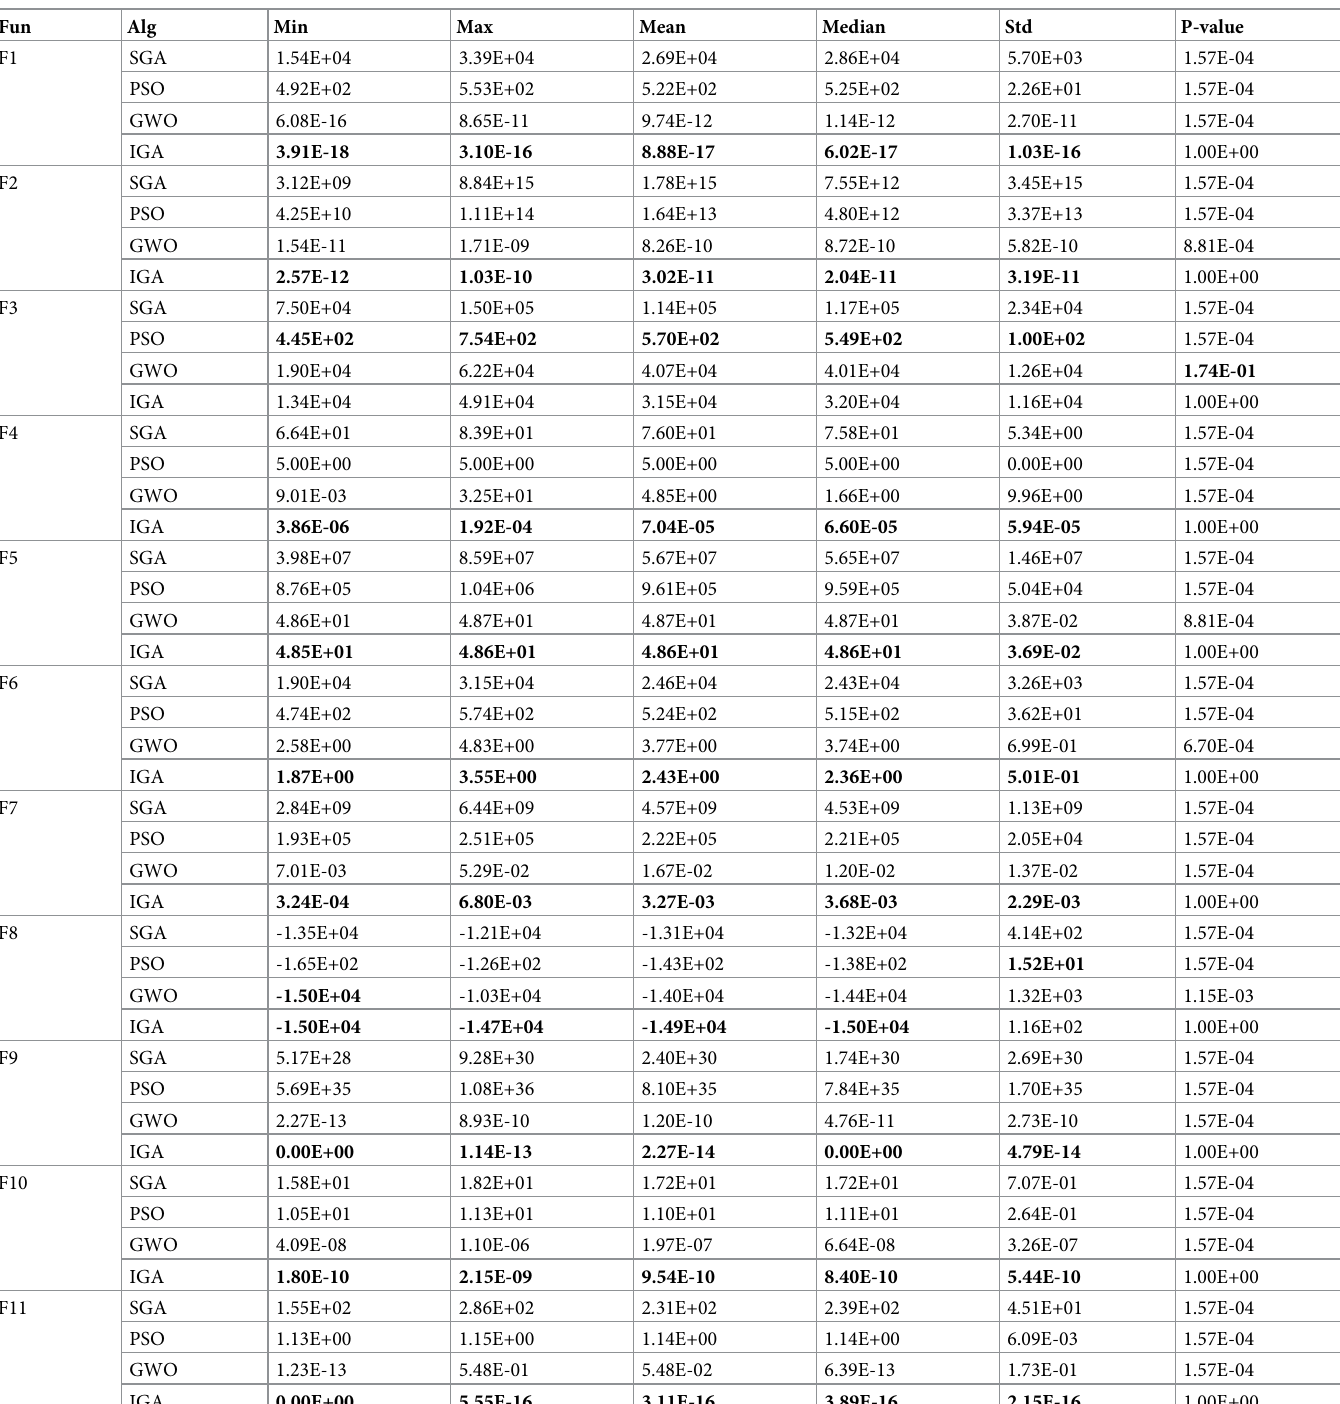
Table 6. Results of test functions (F1-F11) with 50